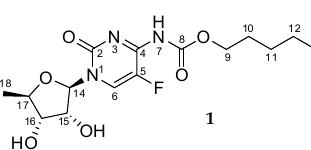
Figure 1. Notation of capecitabine 1 , the most frequently encountered in literature. The atom numbering used throughout this paper is shown.